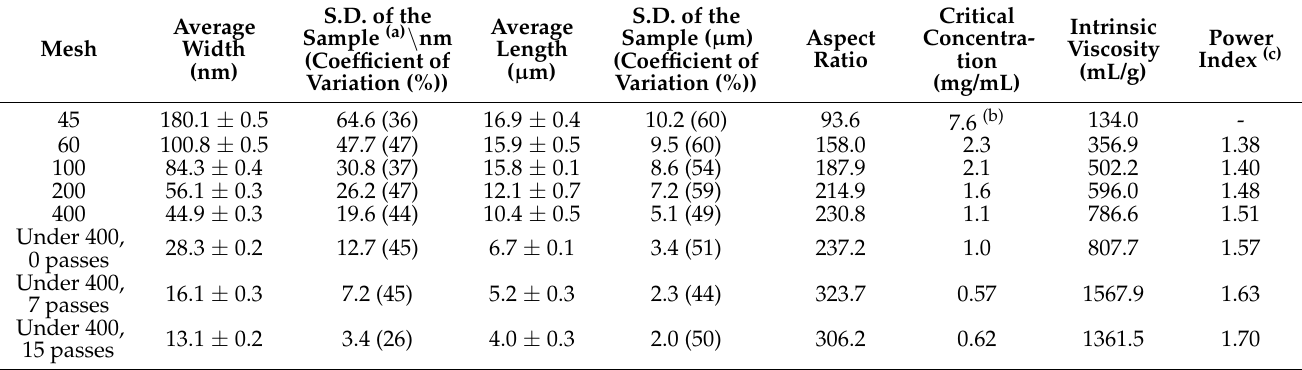
Table 3. Morphological and rheological characteristics of the different fractions by